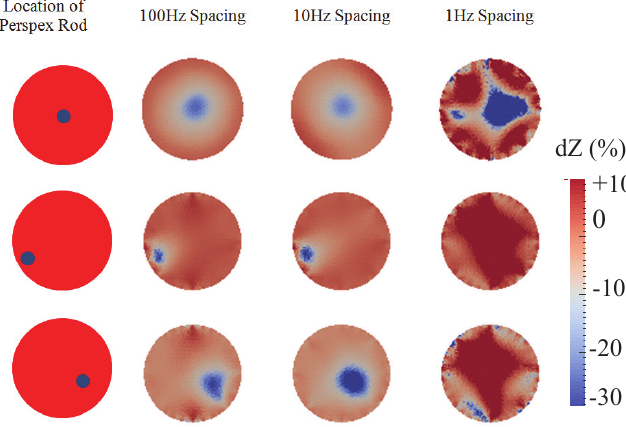
Fig. 4: Results of imaging test. Blue areas represent an increase in impedance. The first column indicates the position of the perturbation in the tank. The remaining columns show the reconstructed images for each frequency group used. Colour bar indicates percentage change in impedance.